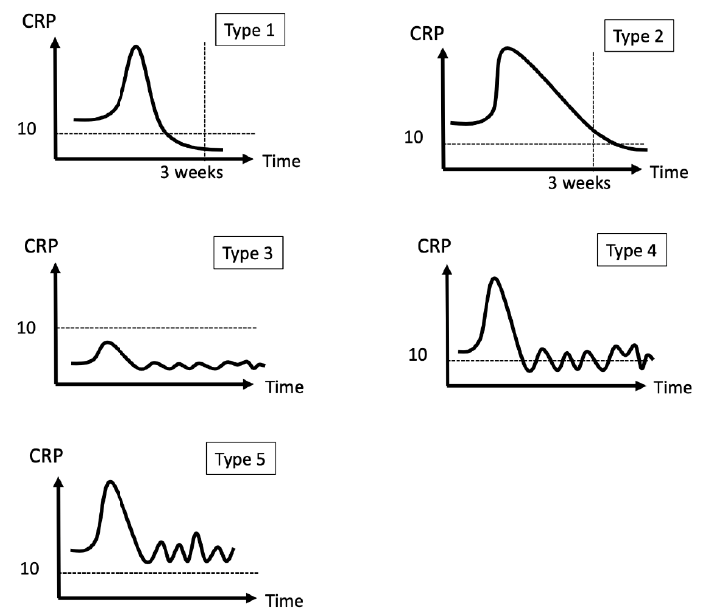
Figure 3. Examples of five CRP patterns. CRP usually elevated right after resection.